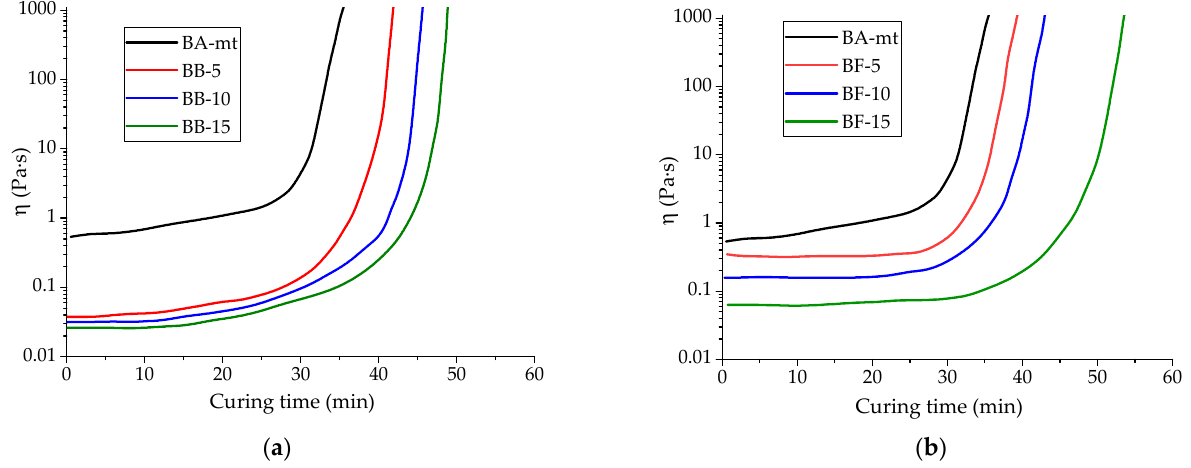
Figure 5. Dependencies of viscosity on curing time at 180 ° C for compositions with BD ( a ) and FUR ( b ).